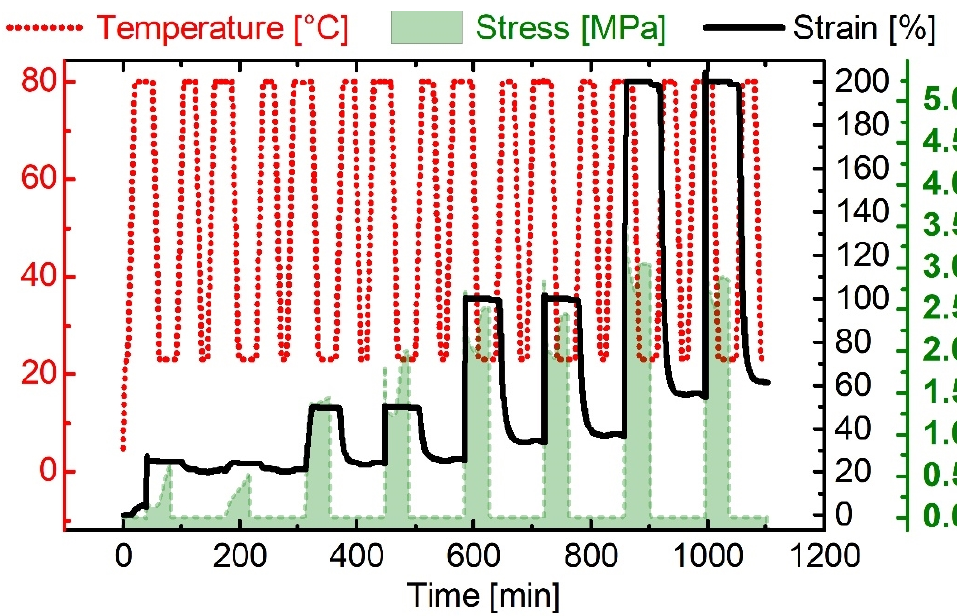
Figure 3. Cyclic DMA measurement protocol for PPG-based TPU ( T high = 80 °C, T low = 23 °C, ε max = 25%, 50%, 100%, and 200%). The evolution of temperature (red dotted line), stress (green area), and strain (black line) are exhibited.